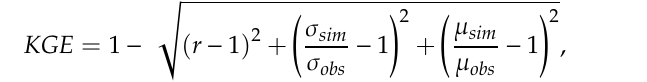
Table 4. Values of Nash–Sutcli ff e E ffi ciency (NSE) and Kling–Gupta E ffi ciency (KGE) for predictions via the LP hysteresis model, main drying, and main wetting